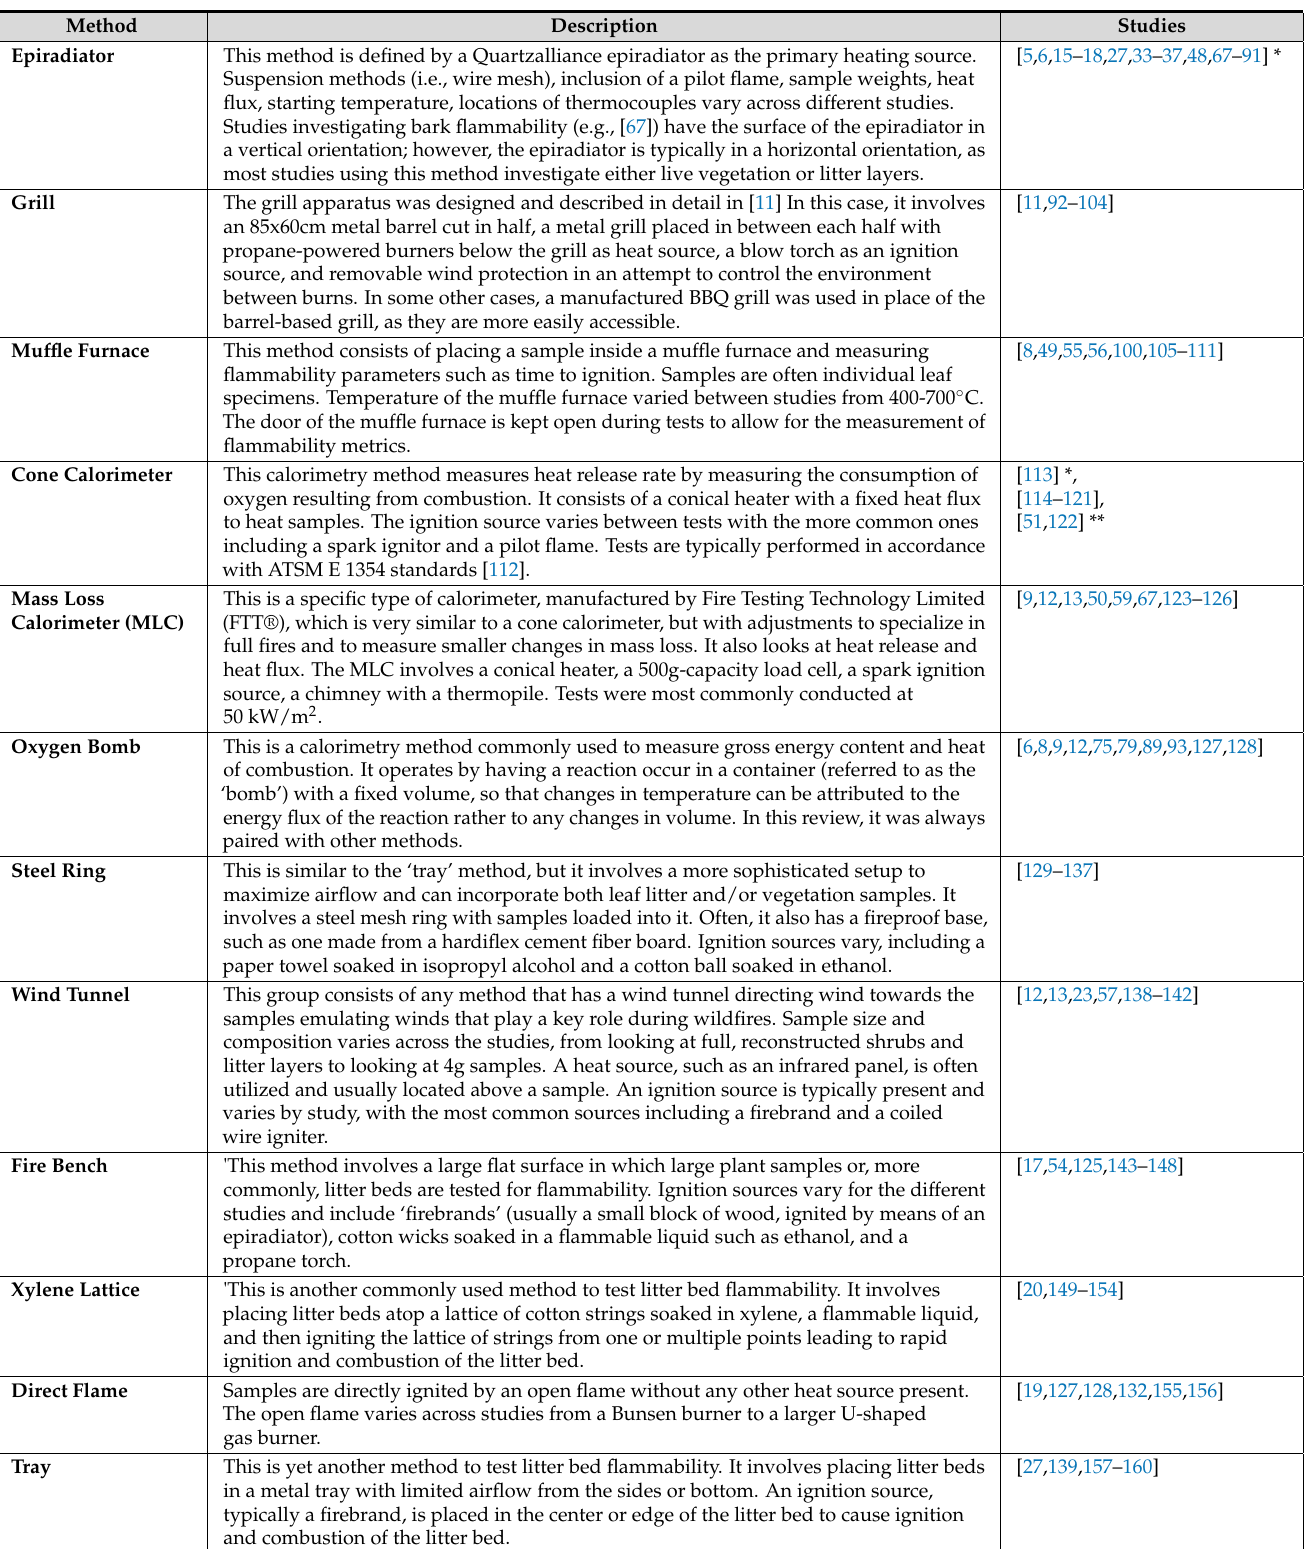
Table A1. Descriptions of each of the flammability testing methods included in Figure 2b and list of studies using each method; for more comprehensive descriptions of flammability testing methods, see